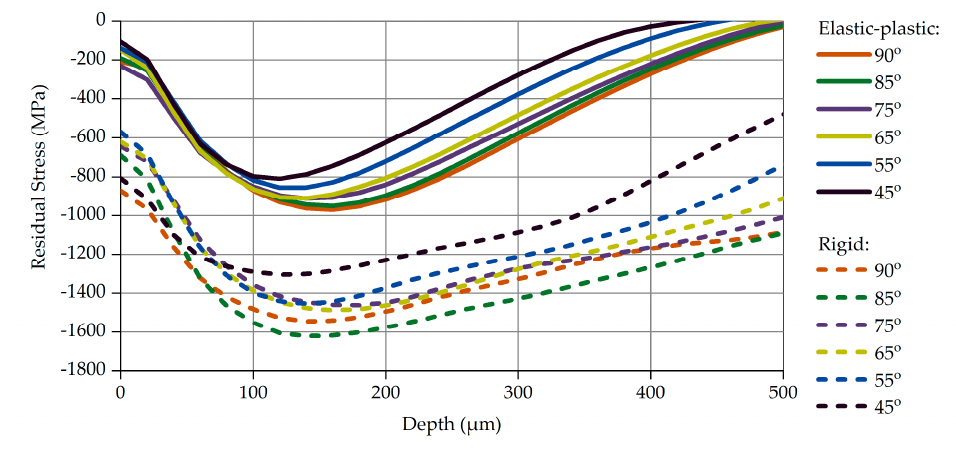
Figure 6. Compressive Residual Stress profiles, for various impact angles.